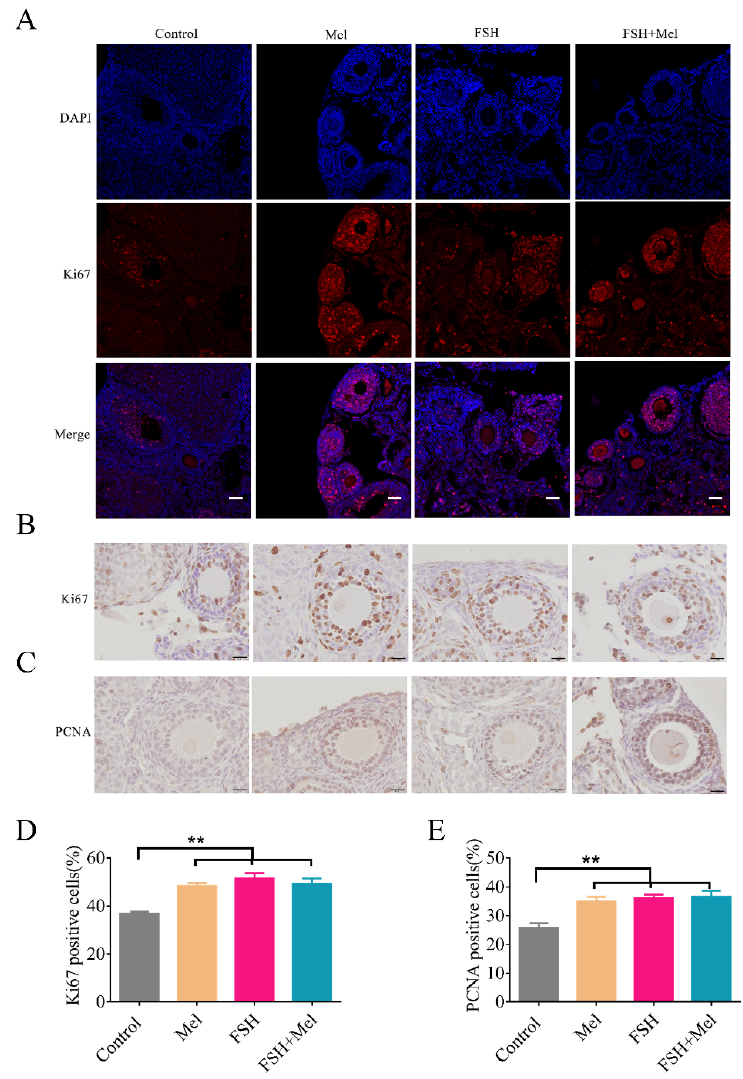
Figure 2. Effect of Mel on the proliferation of ovarian cells. ( A ) Detection of Ki67 expression level by immunofluorescence (IF) ( A ), immunohistochemistry (IHC) ( B ). ( C ) Detection of PCNA expression level by immunohistochemistry (IHC). ( D ) Quantification analysis of the Ki67 expression level. ( E ) Quantification analysis of the PCNA expression level. Horizontal bars denote treatments differing p < 0.01 **.